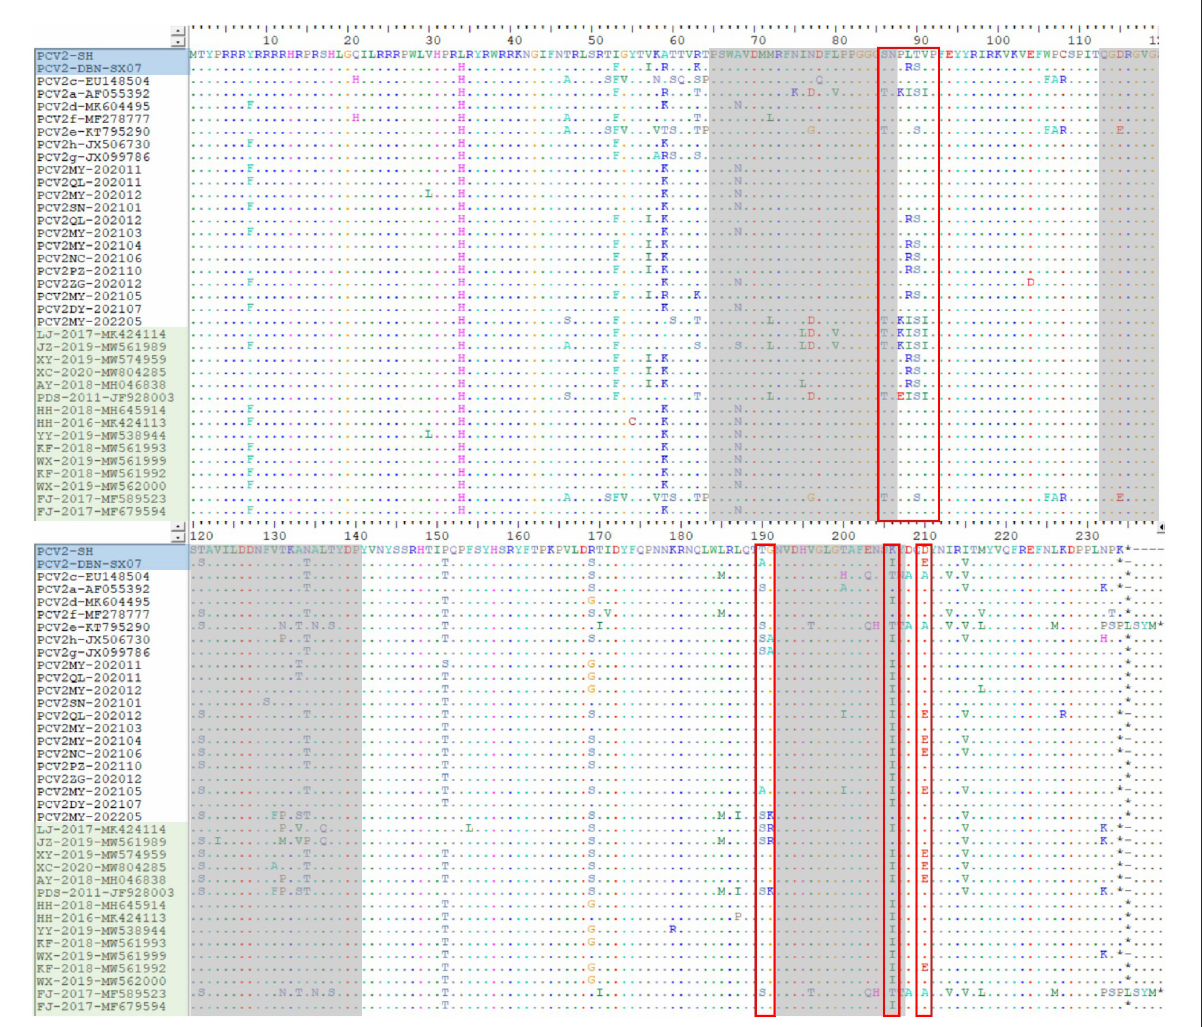
FIGURE3 The unique amino acid sequences encoded by ORF2 of the PCV2 strains. The red open boxes show the typical motifs of ORF2 gene. The gray areas represent the epitope region reported in previous studies, including A (65–87), B (113–139), C (193–207) and D (227–233). The blue area represents the vaccine strains and the green area represents the Chinese reference